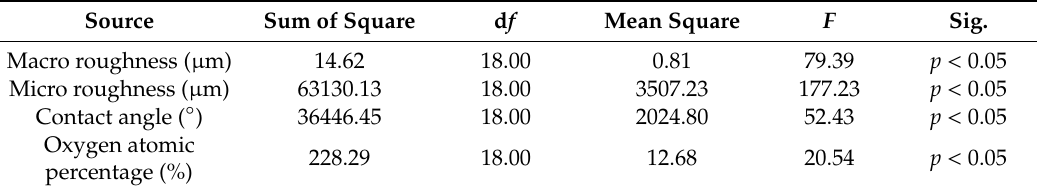
Table 3. Results of one-way